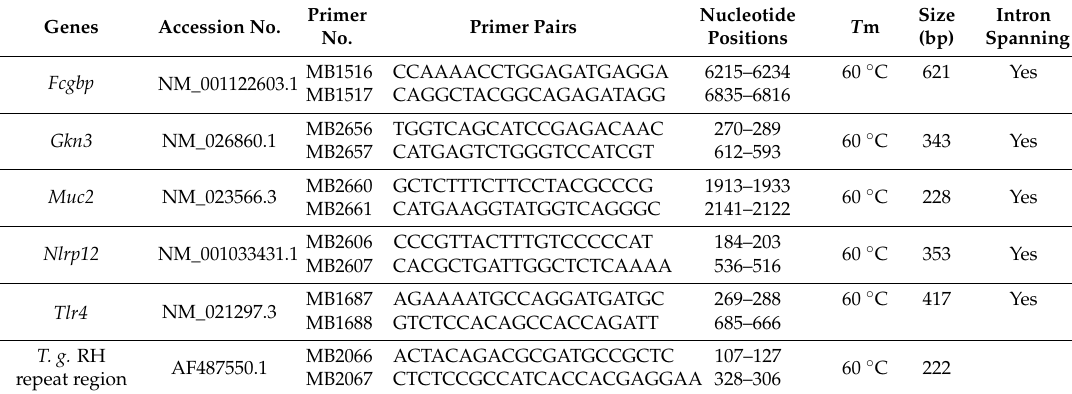
Table 1. Oligonucleotides used for (RT)-PCR analysis and calculated size of the products. Genes Accession